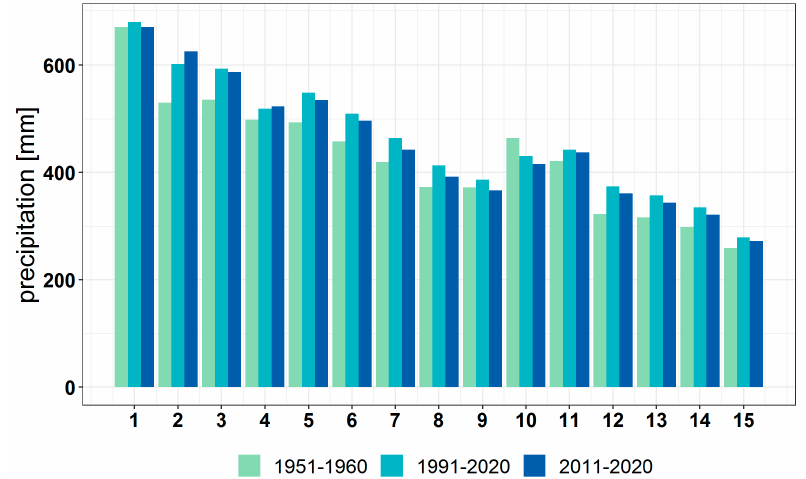
Figure 14. The variation of AP VS over the analyzed period for the main forest types.